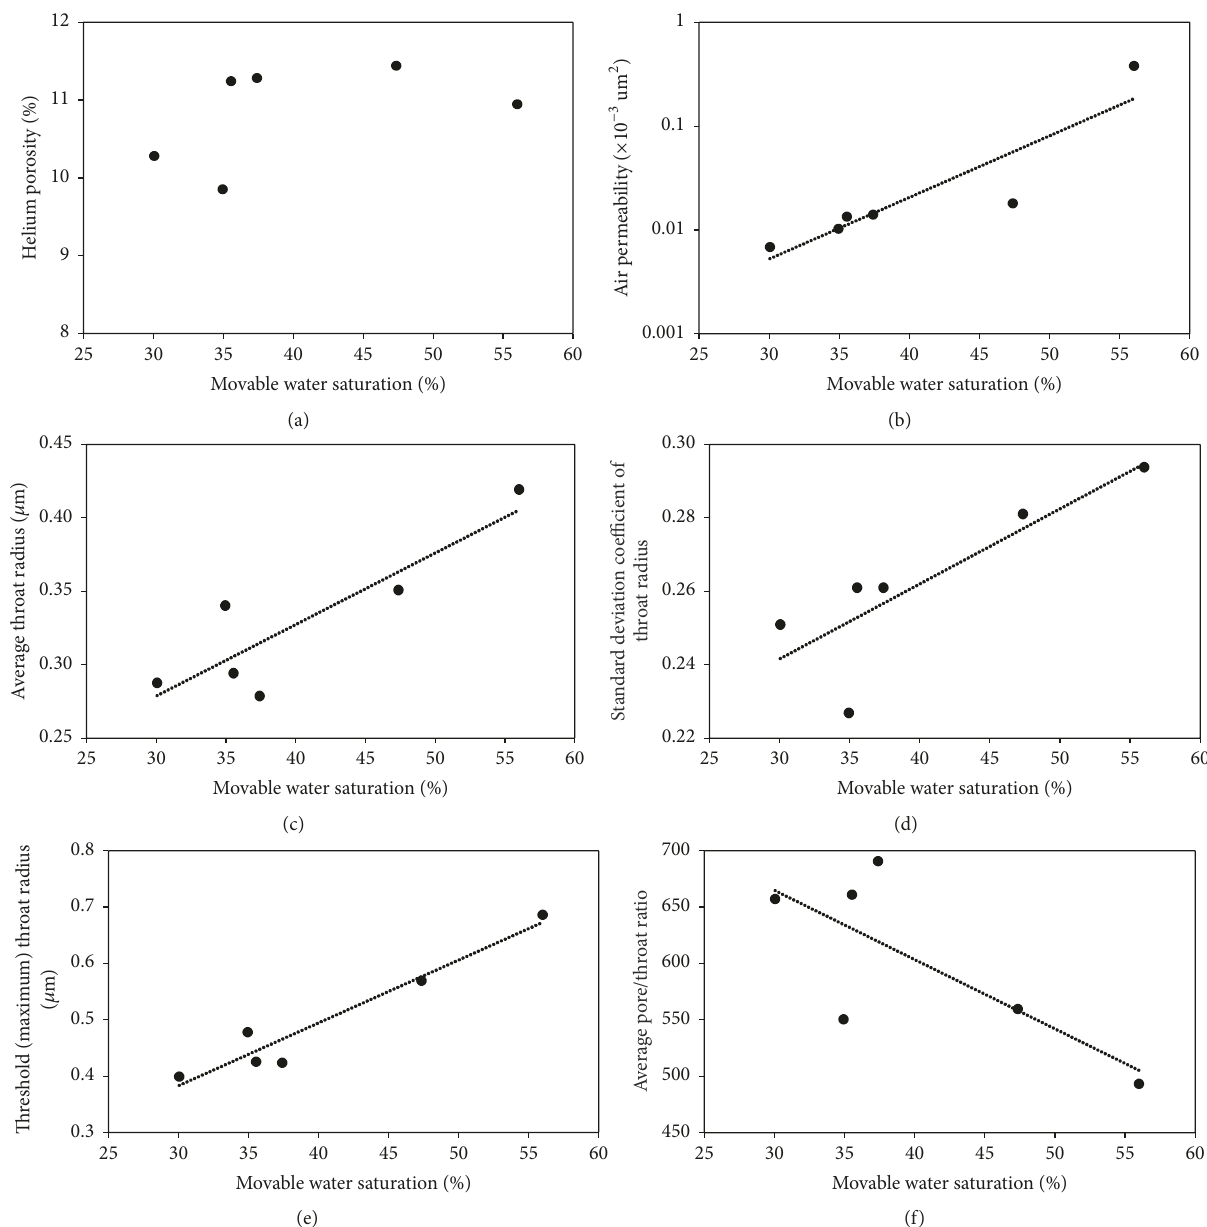
Figure 13: The correlation of the combination parameter of pore-throat structure ( 𝜀 ) and total mercury saturation. This implies the relationship between pore-throat structure and valid porosity of the reservoir. The detail of 𝜀 refers to the footnote of Table 1.